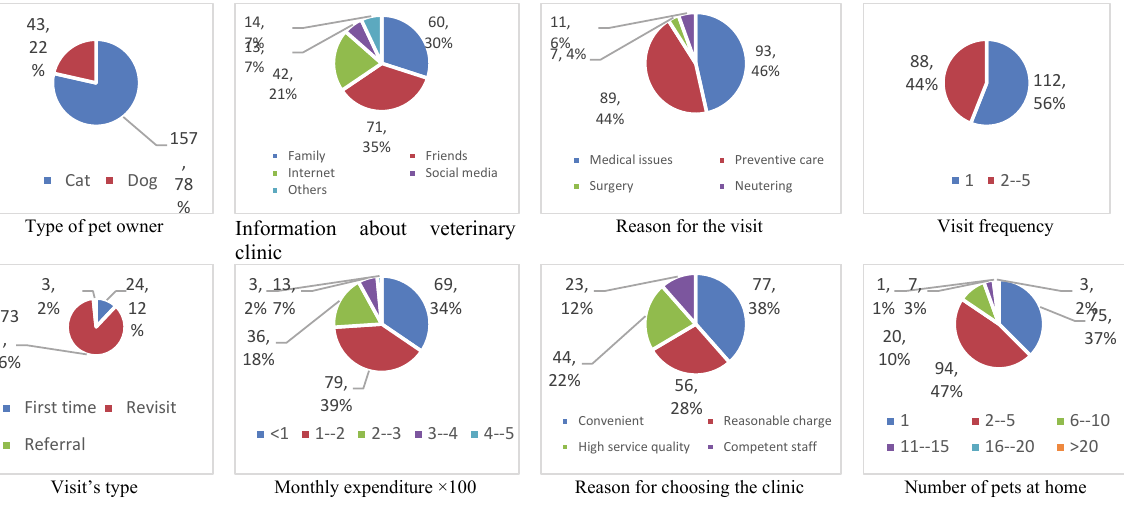
Fig. 2. Pet Owners and Veterinary Clinic Service ( N =200)